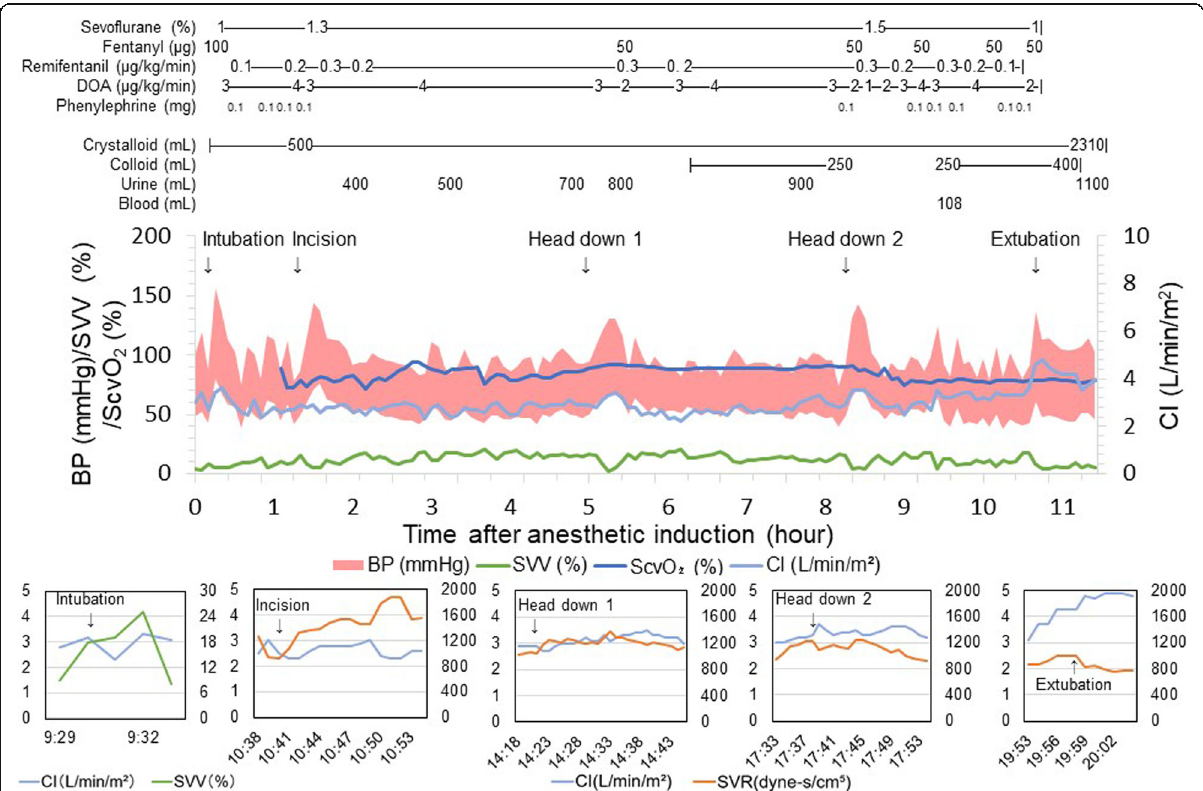
Fig. 2 Anesthesia record of a patient with cardiac sarcoidosis who underwent laparoscopy-assisted total proctocolectomy. DOA dopamine, BP blood pressure, SVV stroke volume variation, CI cardiac index, ScvO 2 central venous oxygen saturation, SVR systemic vascular